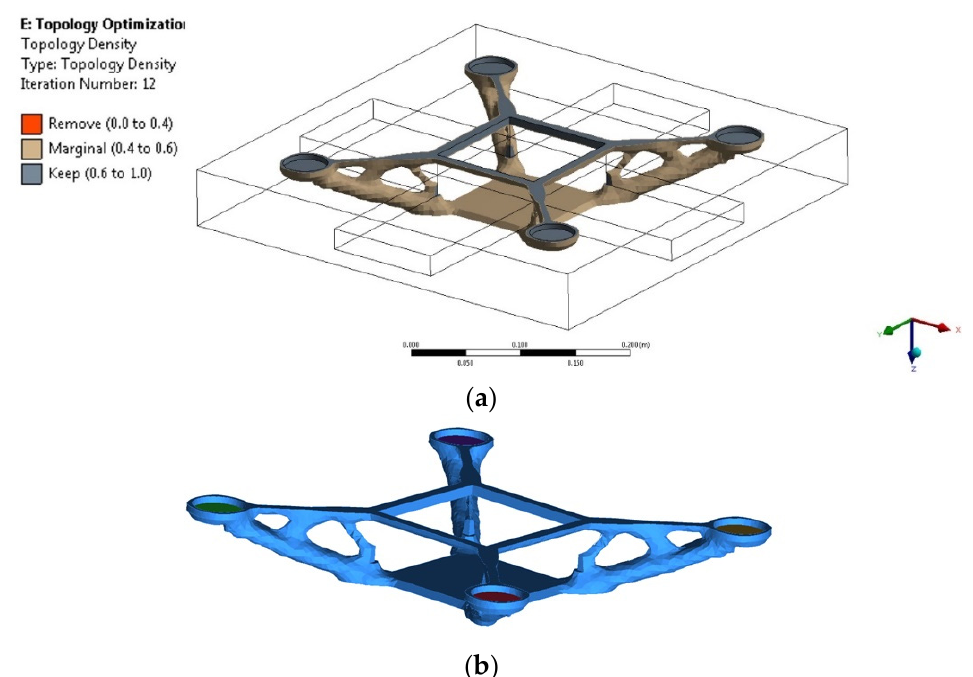
Figure 8. Topology optimization result with monocoque model. ( a ) Topology density tracker, ( b ) Topology optimized model.